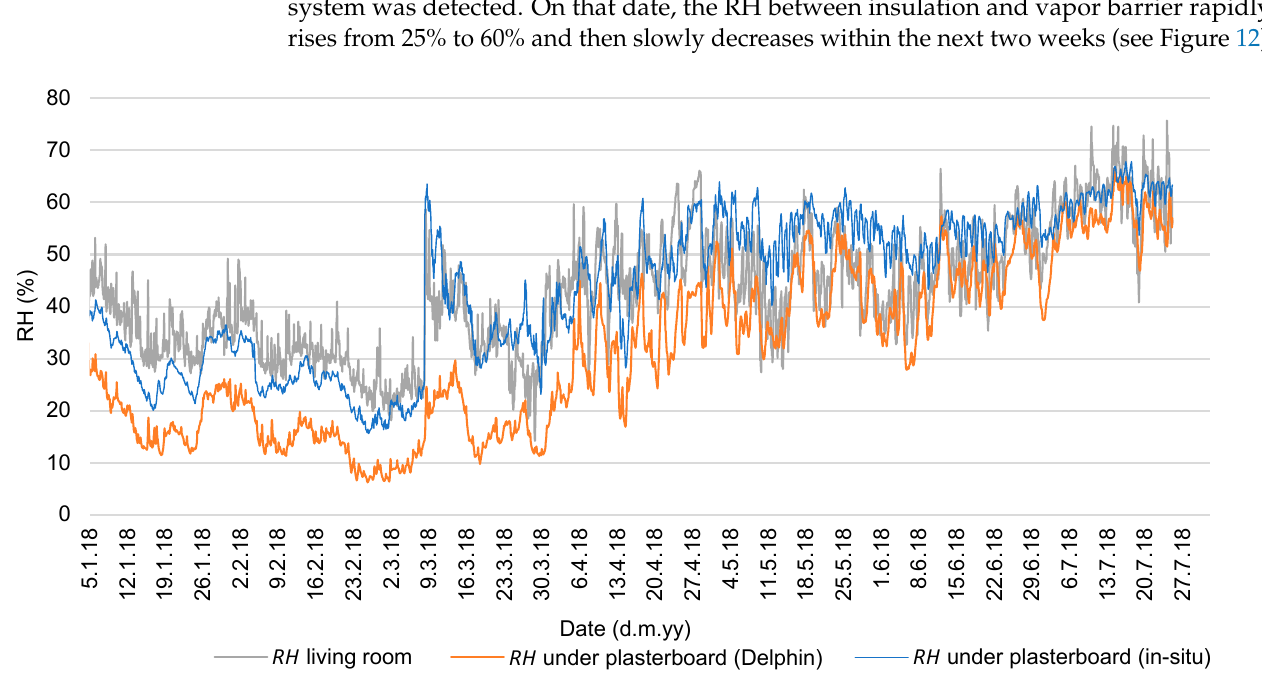
Figure 12. Relative humidity of the living room wall between the insulation and vapor barrier: measured RH (blue line), simulated RH (orange line), and indoor RH (grey line). Simulated RH between the insulation and vapor barrier follows the trend of the indoor RH, although it is 5 to 10% lower than the level measured during the heating season (see Figure 12).